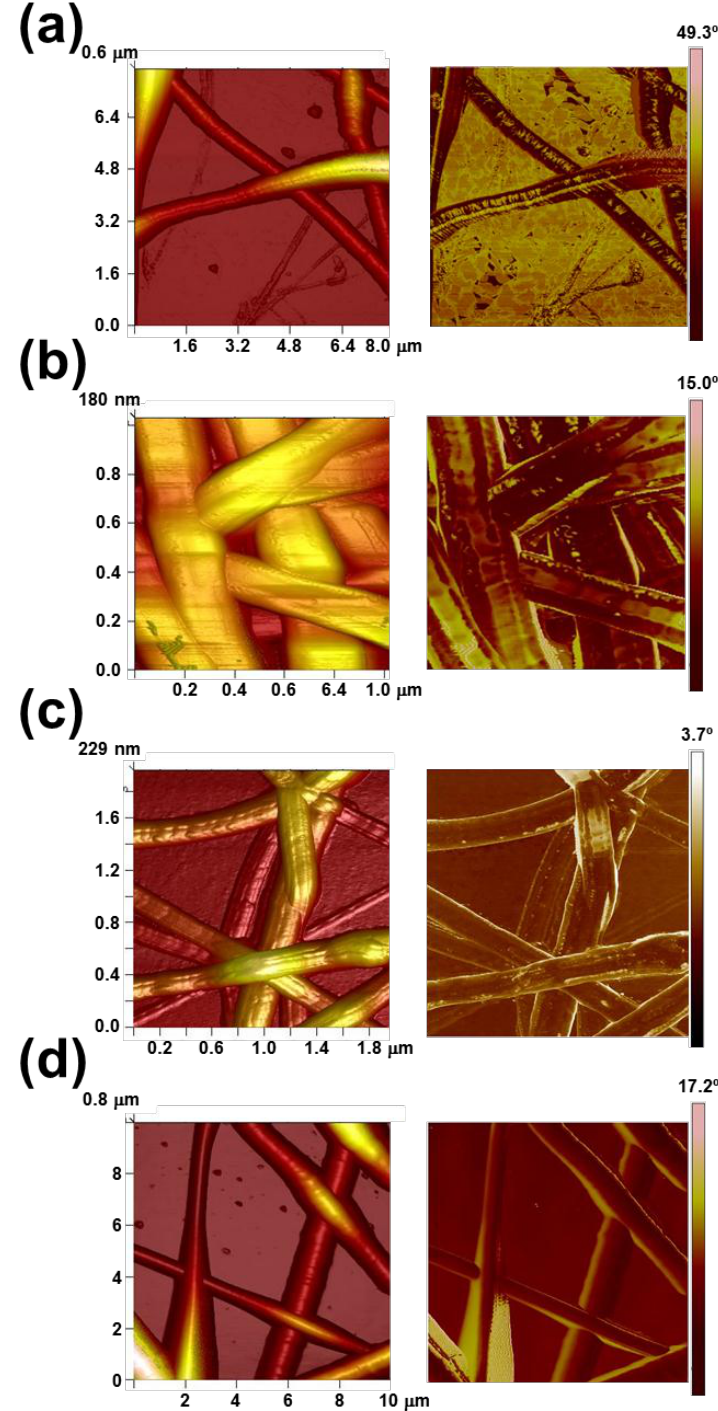
Figure 4. AFM images of ( a ) unloaded PE44, ( b ) PE44/GA-S1, ( c ) PE44/GA-S2 and ( d ) PE44/GA-L electrospun fibers: 3D topography (left) and phase (right) images. The scan window size was adjusted in each case according to the diameter of the fibers (see Table 1): ( a ) 8 × 8 µm 2 ; ( b ) 1 × 1 µm 2 ; ( c ) 2 × 2 µm 2 ; and ( d ) 10 × 10 µm 2 .